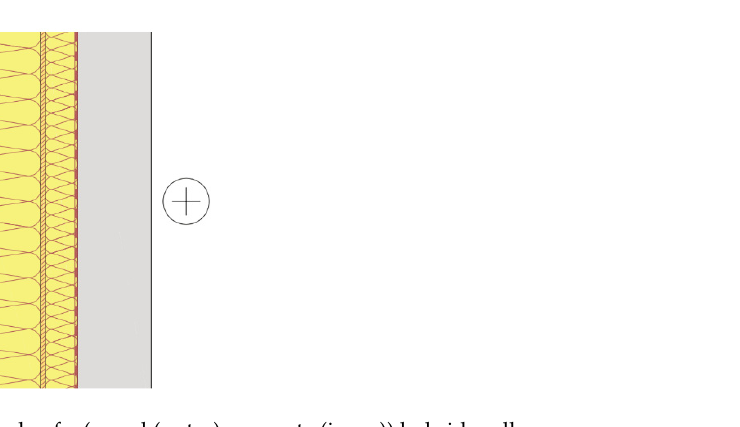
Figure 6. An example of a (wood (outer)–concrete (inner)) hybrid wall.